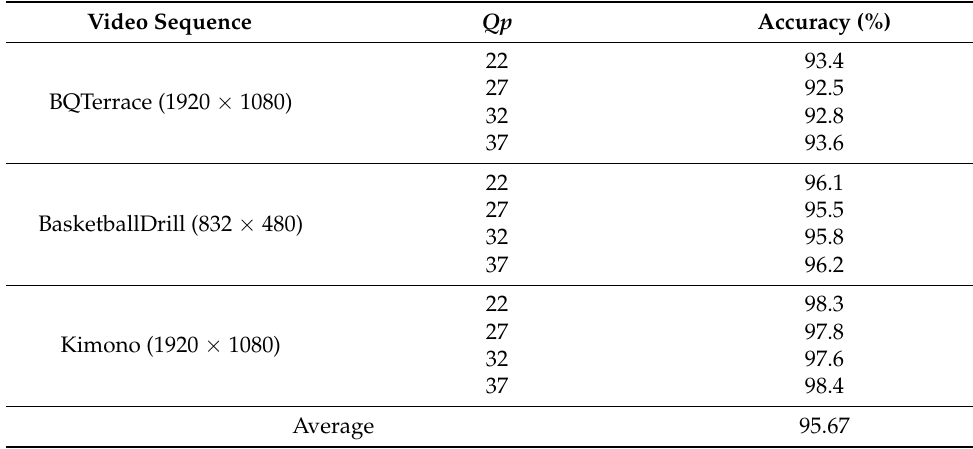
Table 4. The prediction accuracy over different sequences and Qp s. Video